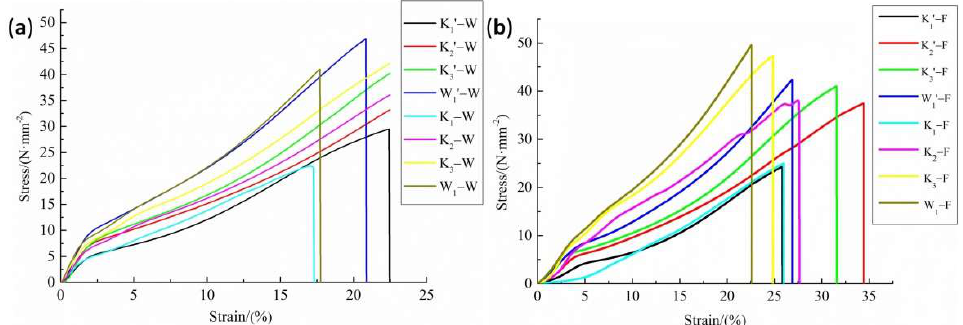
Figure 1. Fracture stress–strain curves of the tested specimens. ( a ) Warp direction; ( b ) fill direction.